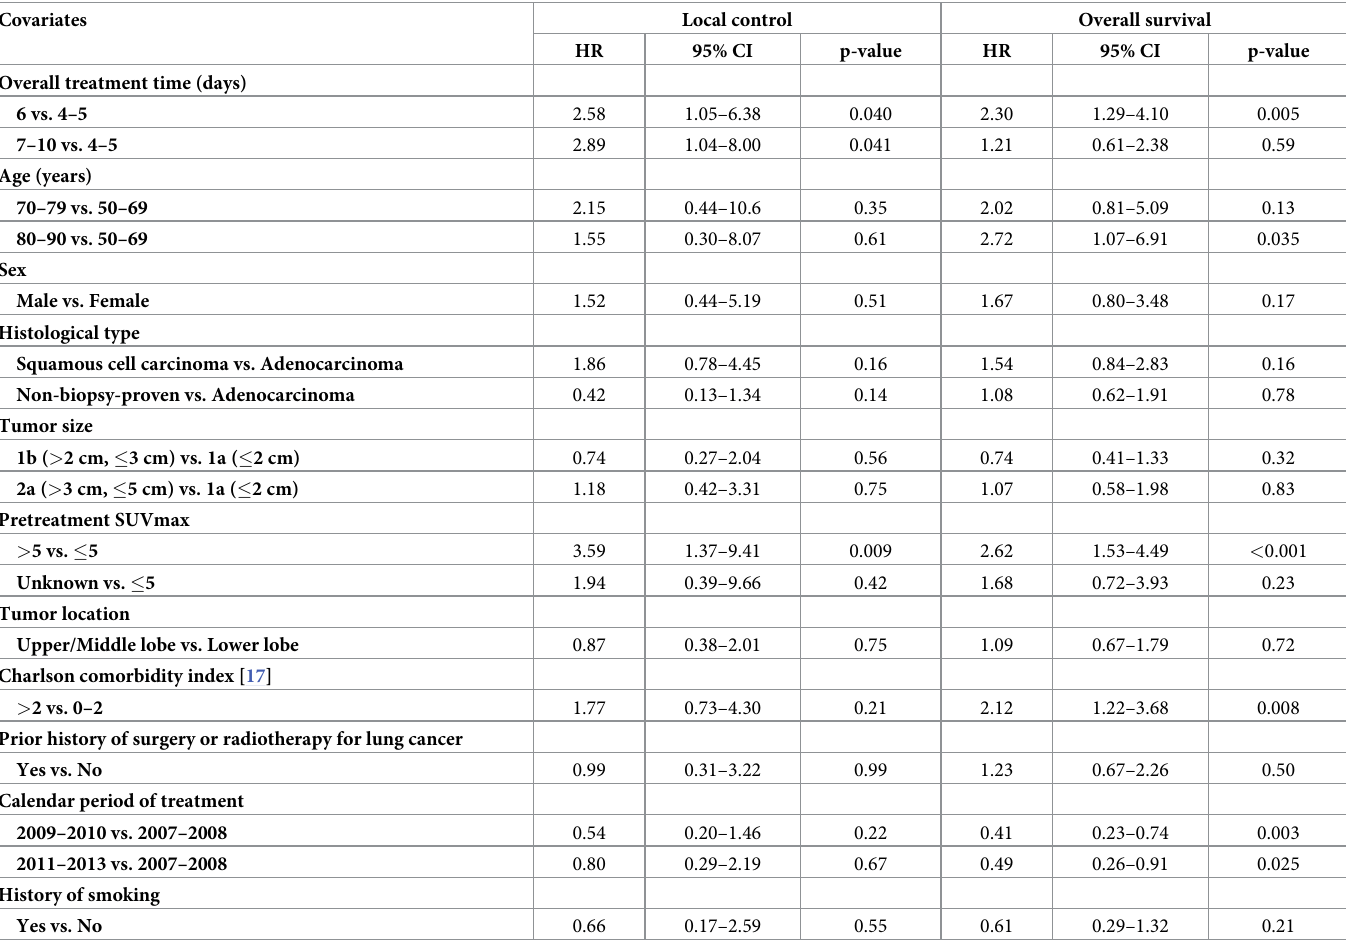
Table 3. Multivariable analyses for local control and overall